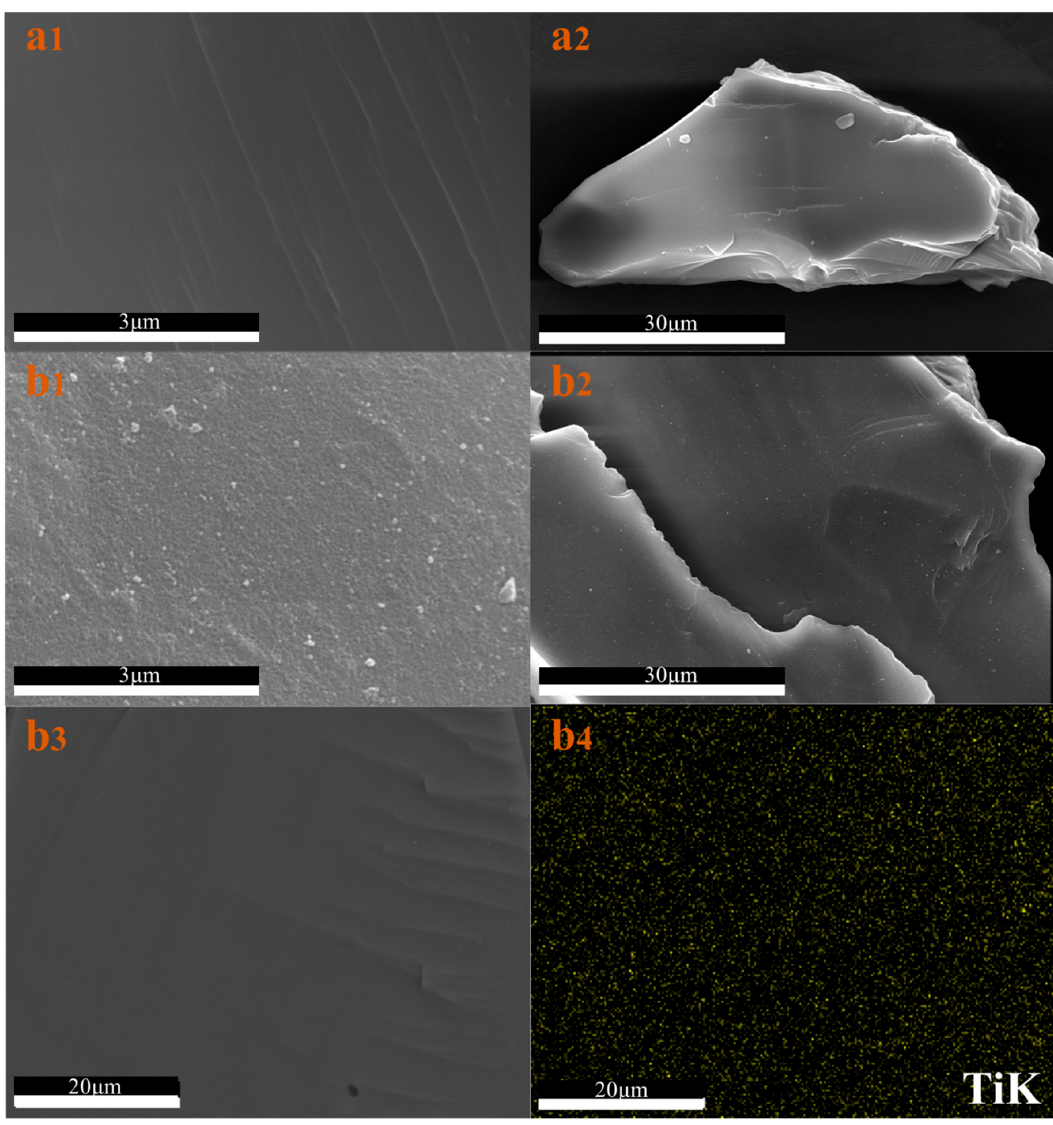
Figure 3. Surface morphologies of pure quartz sand ( a ) and TiO 2 / quartz sand ( b ).